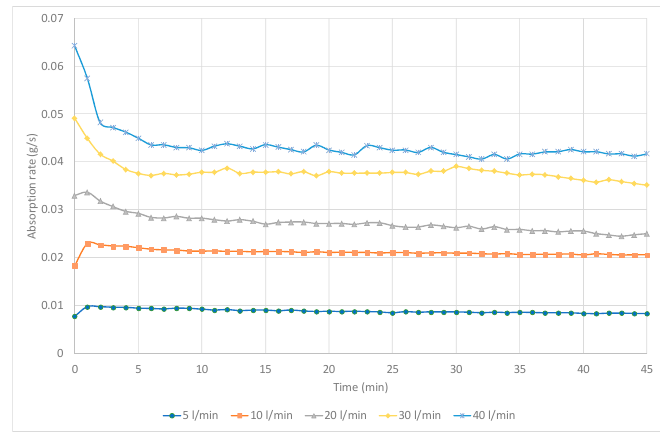
Figure 6. Absorption rates at each flow rate within the reactor at a 2:1 CaCl 2 :VM ratio.